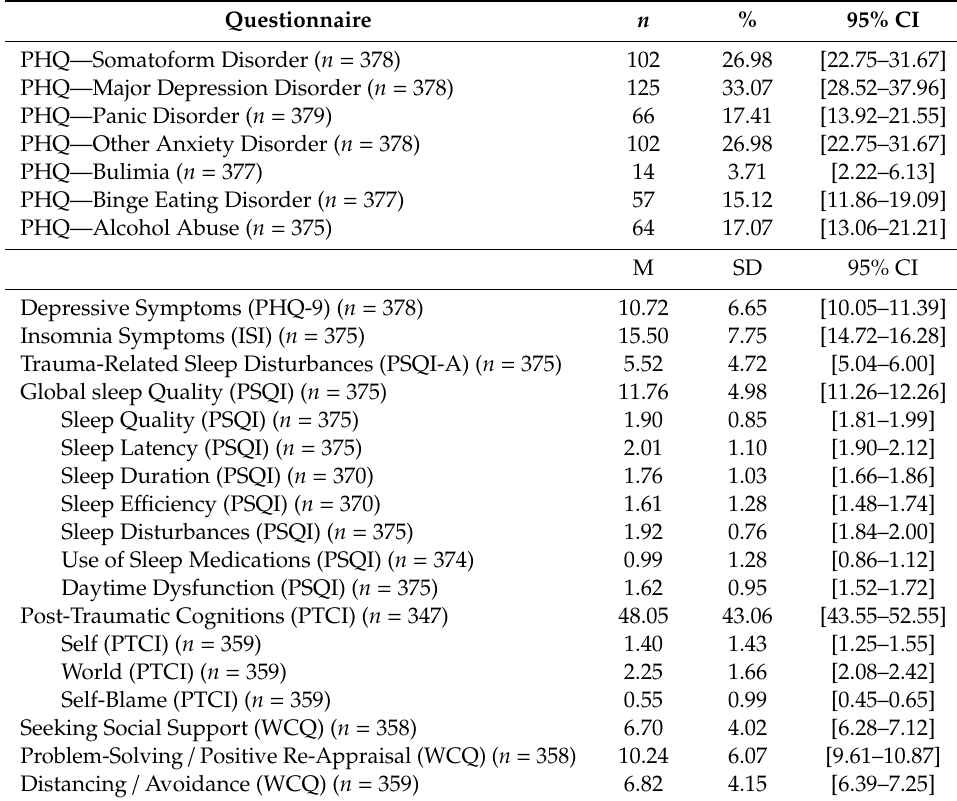
Table 2. Results on self-report questionnaires ( n = 347–378 a